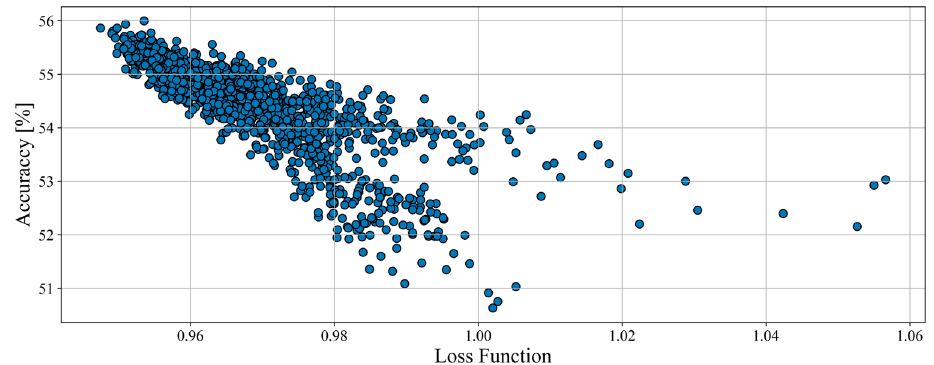
Figure 5. Accuracy and value of loss function of structures examined during the structure optimi- zation process for loaders.